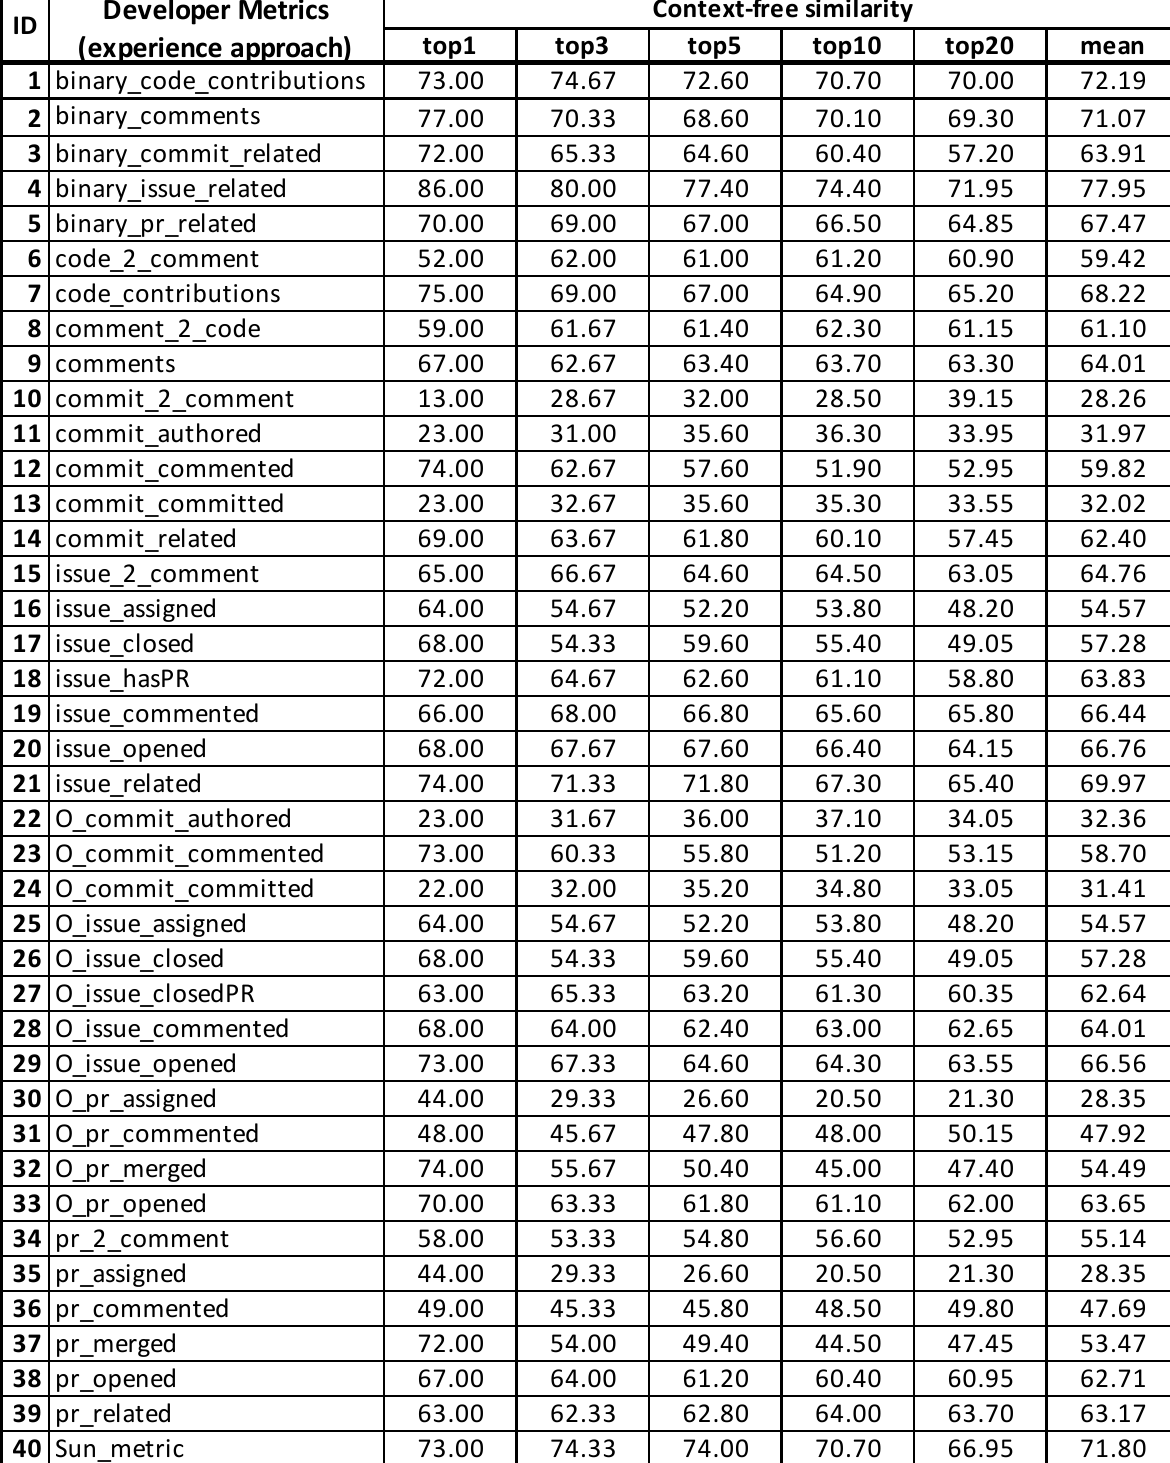
Table A3. All developer metrics all scores to evaluate with the experience approach